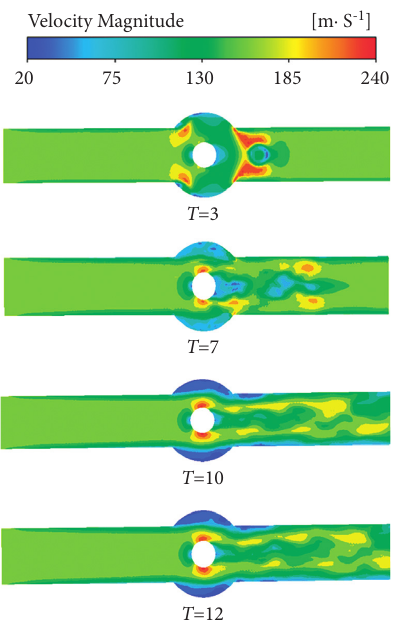
Figure 4: Velocity contours.